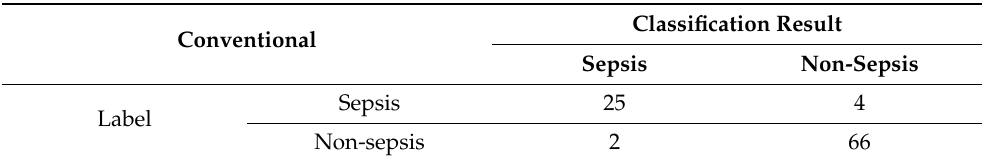
Table 4. Confusion matrix of full scratch model which trains only target domain. Classification accuracy achieved 93.9% (92/98).